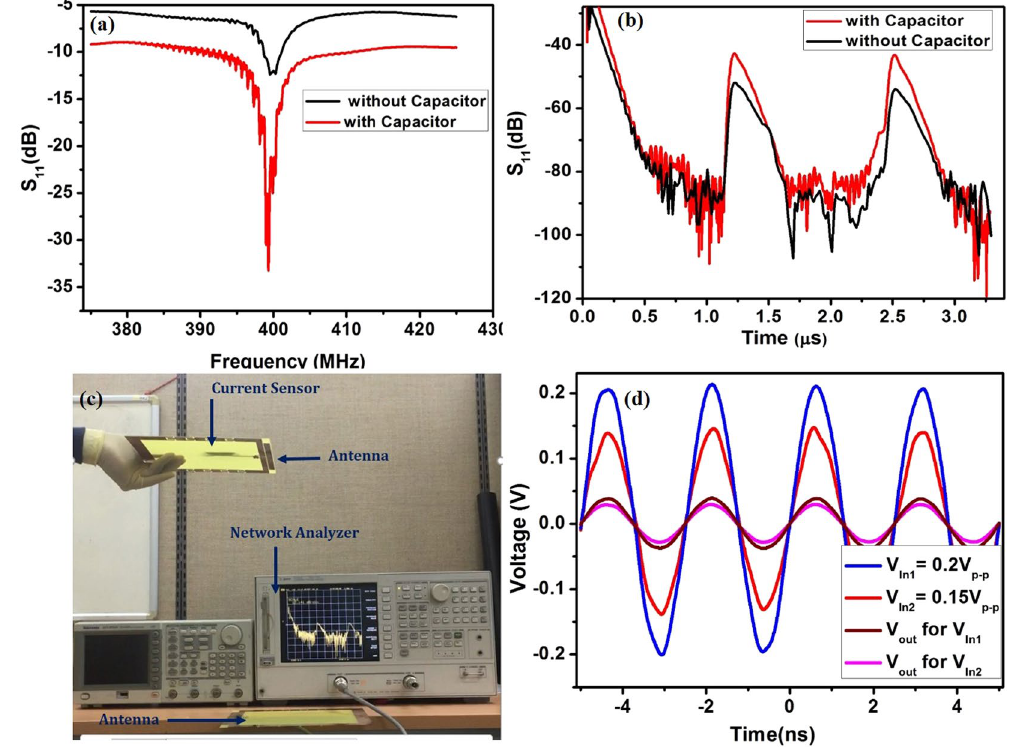
Figure 6. S 11 response for one-port SAW reflective delay line with and without capacitor for impedance matching in ( a ) the frequency domain, ( b ) the time domain, ( c ) Wireless readout distance testing in terms of RF powers from the network anlayazer, ( d ) AC voltages obtained from the second IDT-type reflector in terms of different input peak-to-peak